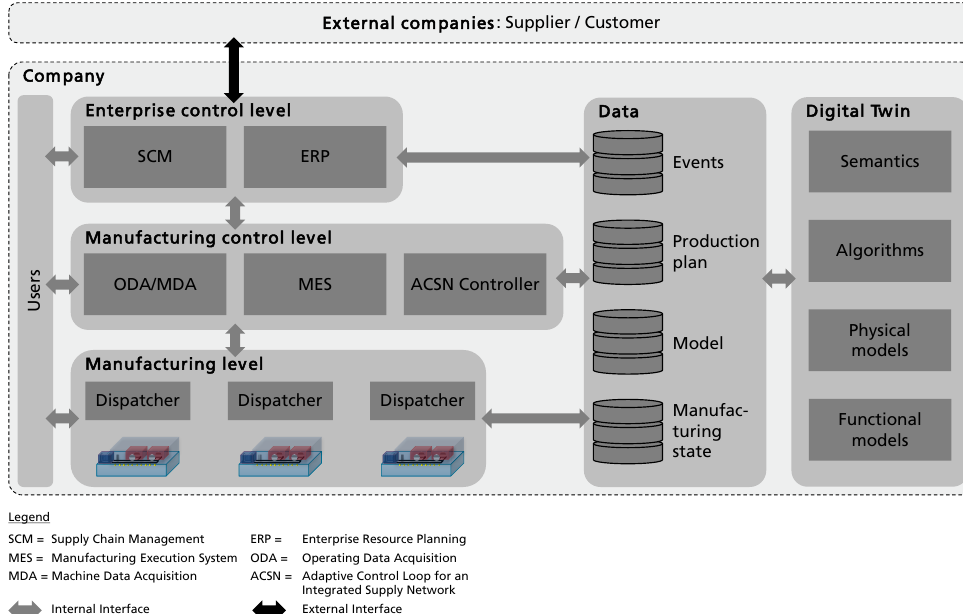
Figure 7. Architecture for event processing of supply network